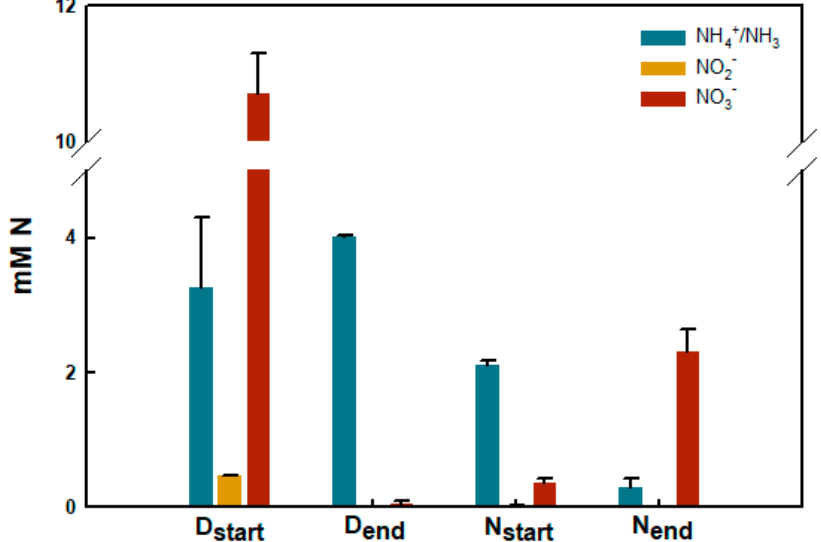
Figure 5. Concentration of NH 4 + / NH 3 , NO 2 − and NO 3 − at T = 0 and end of denitrification (D start / D end ; Reactor #6 biobeads and liquid) and nitrification (N start / N end ; Reactor #3 biobeads and liquid), measured by colorimetric assays. Samples were taken before the addition of biobeads (start) and after incubation under denitrifying and nitrifying conditions (end). The results from 2017 are presented.